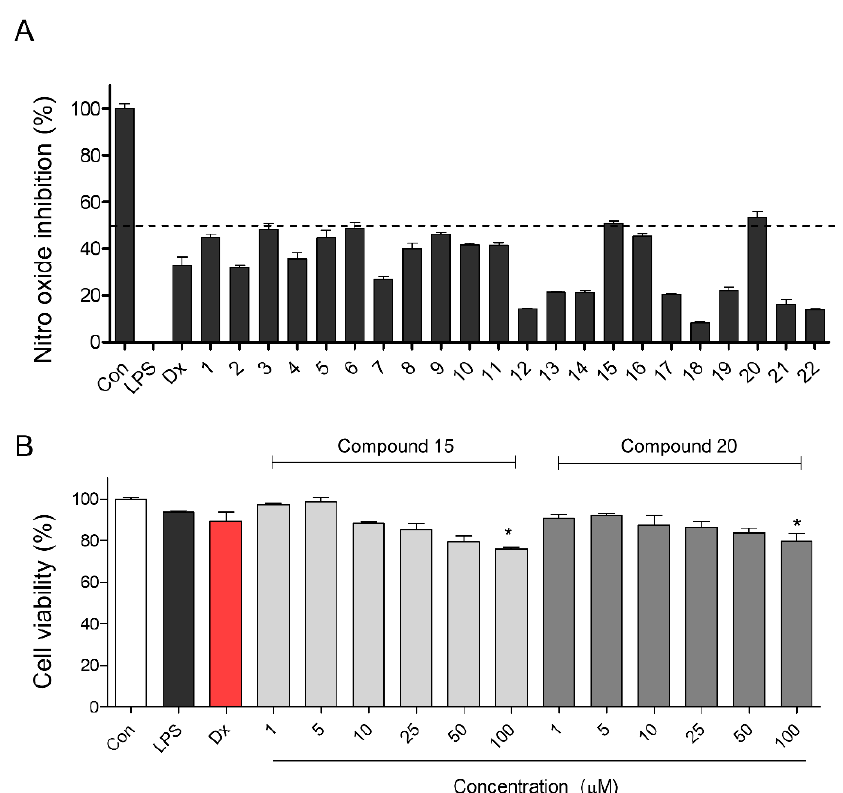
Figure 3. Nitric oxide screening in P. oleracea constituents in RAW 264.7 cell line. ( A ) NO screening was evaluated among 22 constituents in P. oleracea. NO screening was performed as triplicate tests, and results are expressed as means ± standard error of the mean (SEM). ( B ) For selected compounds 15 and 20, MTT assay was performed at 1 to 100 µ M. MTT assay was performed as triplicate tests, and results are expressed as means ± SEM. An unpaired Student’s t- test was used for statistical analysis. * p < 0.05 versus Con. Con: control, LPS: lipopolysaccharide, Dx: